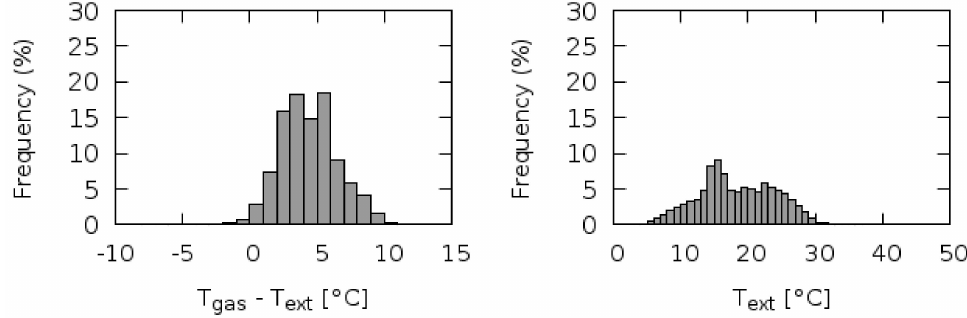
Figure 11. Frequency distributions of difference between internal gas intake temperature and external ambient temperature ( left ) and external air temperature ( right